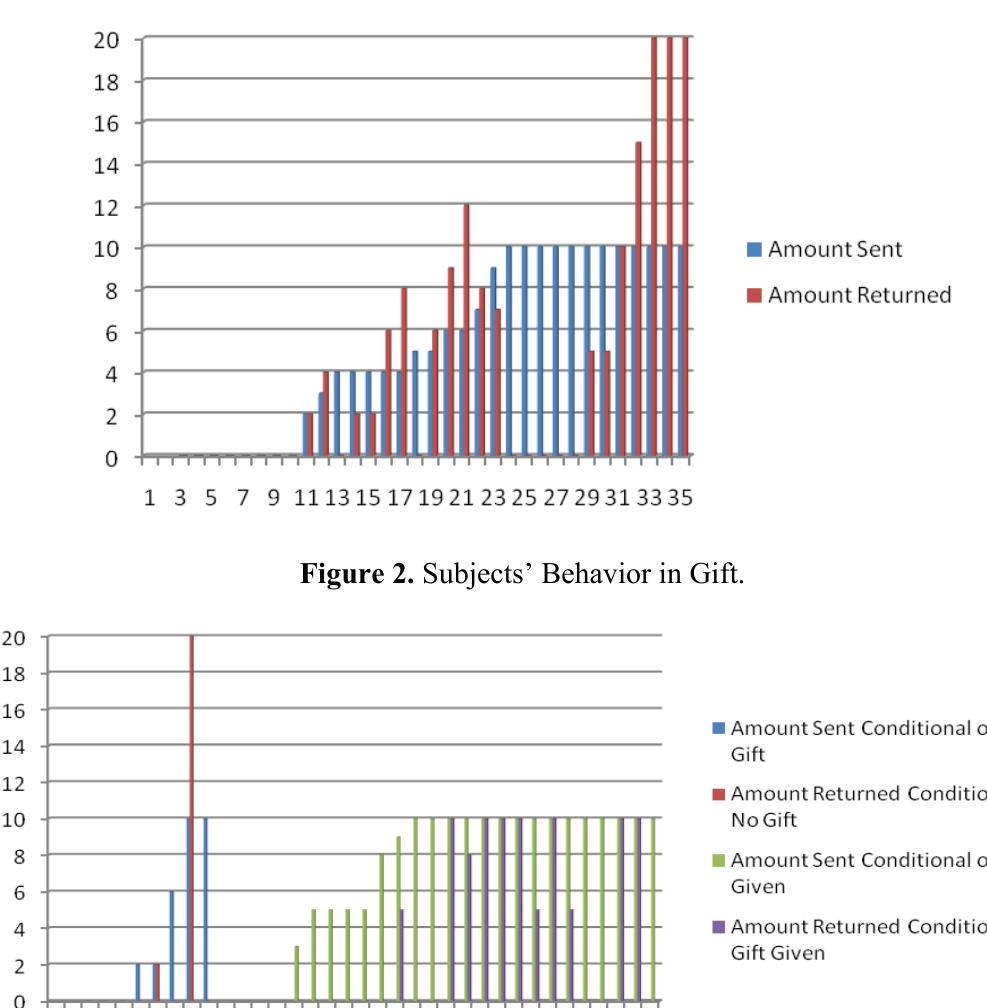
Figure 1. Subjects’ Behavior in Baseline.